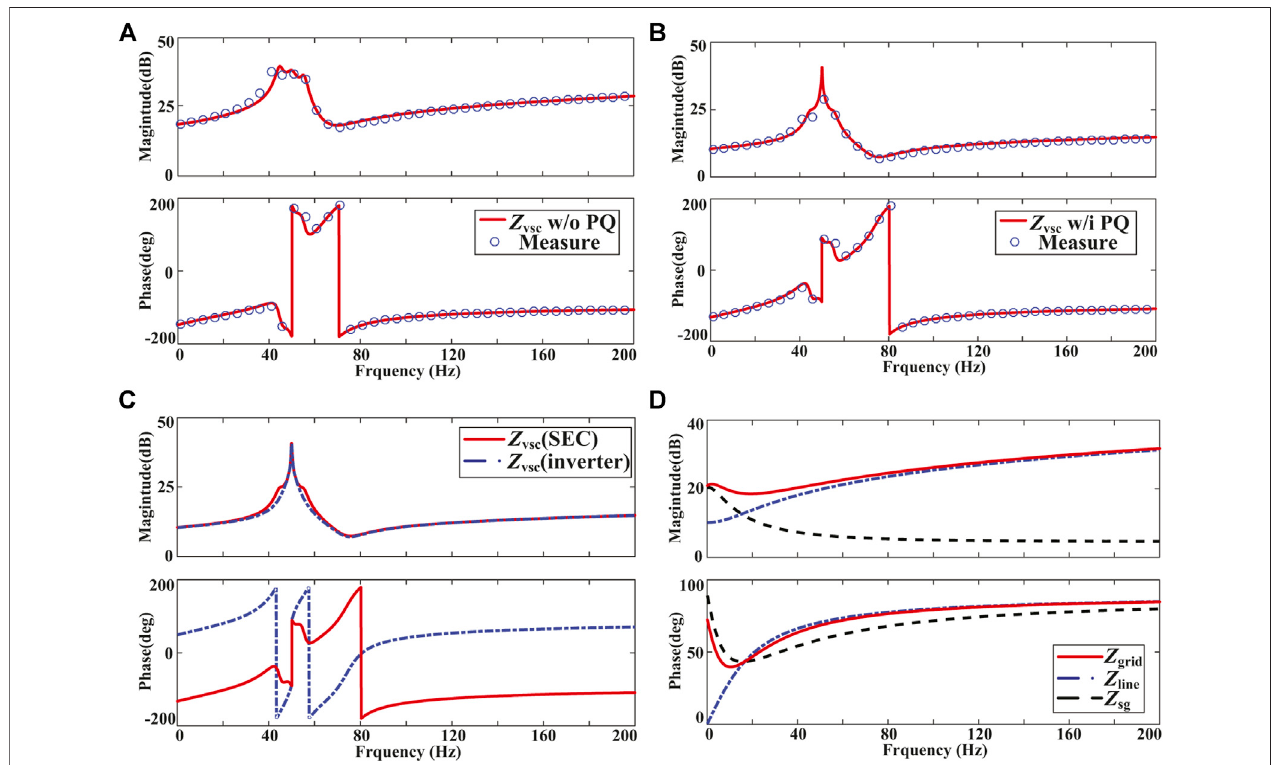
FIGURE 4 | Validation and comparison of the impedance models; (A) validation of Z vsc ( s ) without PQ-control; (B) validation of Z vsc ( s ) with PQ-control; (C) comparison of Z vsc ( s ) for the SEC and the inverter; and (D) comparison of Z sg ( s ) , Z line ( s ) and Z grid ( s ) .